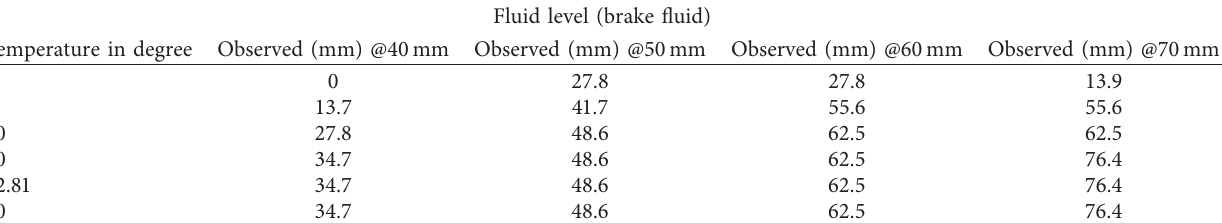
Table 3: Measurements at various